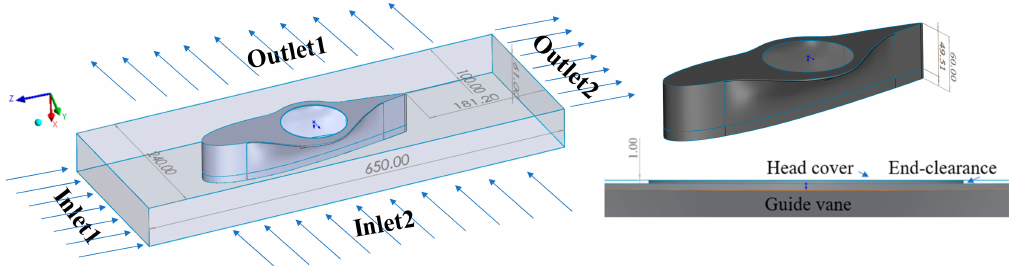
Figure 5. Computational model and relative parameters (mm).